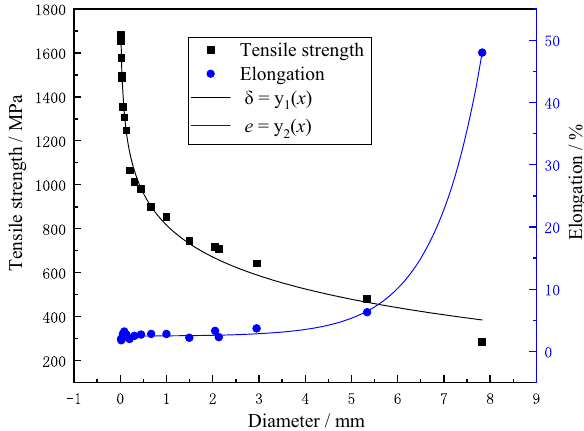
Figure 4: Mechanical properties of as - drawn wires with di ff erent diameters during multi - pass continuous